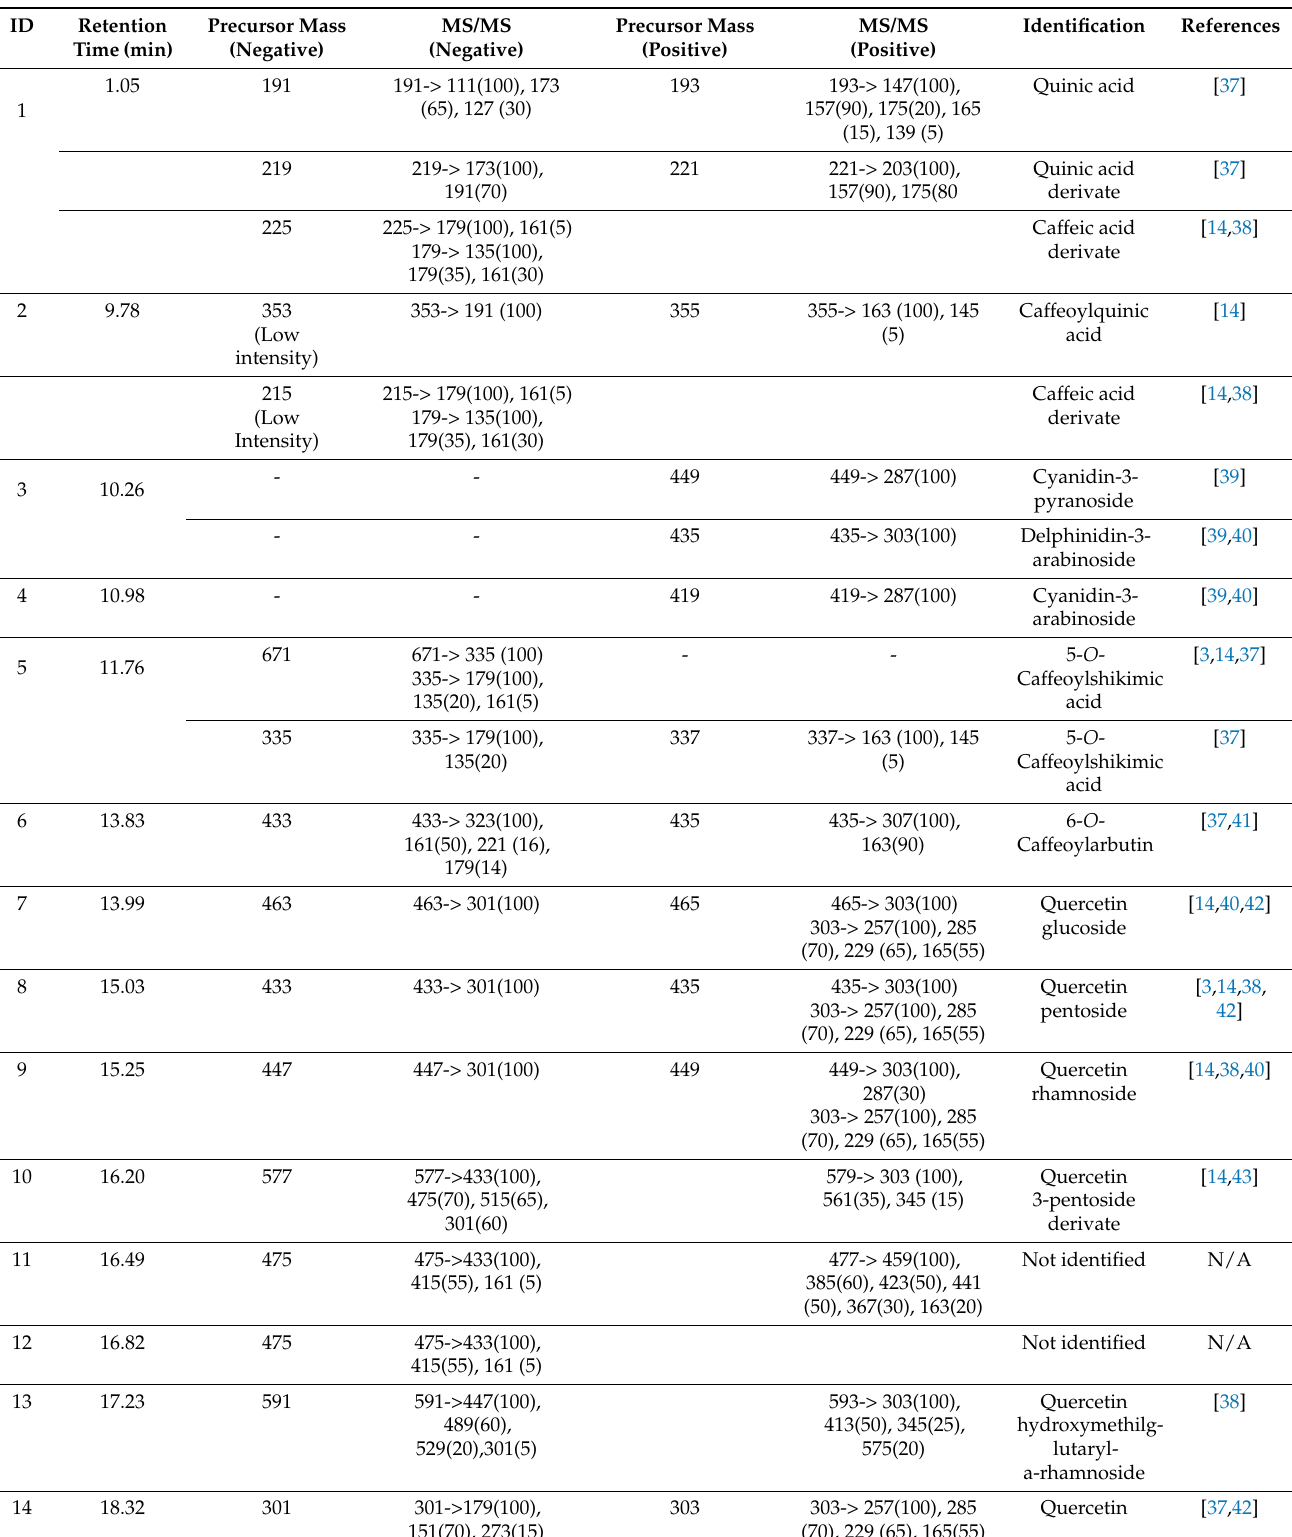
Table 3. Tentative Identificationof PhenolicCompounds in V. floribundum Kunth byHPLC-DAD/ESI-MS n